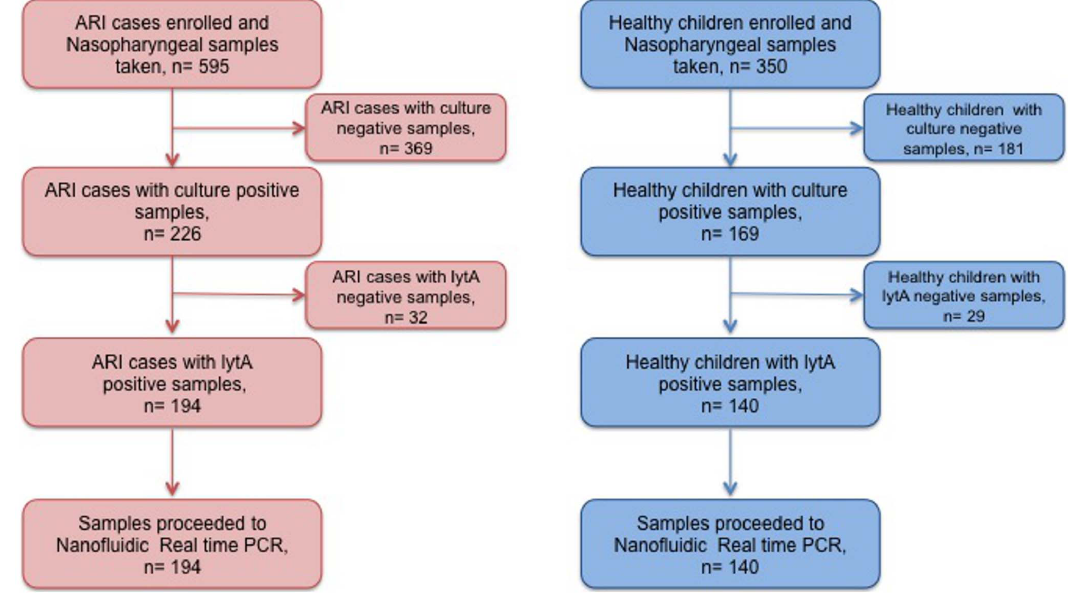
Figure 1. Participants recruited into the study, and their nasopharyngeal samples. Half of the aliquot of nasopharyngeal samples were cultured overnight in 5% sheep blood agar with 5% CO 2 at 37 u C. DNA was extracted directly from the other half of the aliquot of the nasopharyngeal samples which yielded alpha hemolytic colonies and positive Optochin test. DNA was subjected to lytA PCR to confirm pneumococcus; and lytA positive samples were then processed for molecular serotyping in the nanofluidic real time PCR